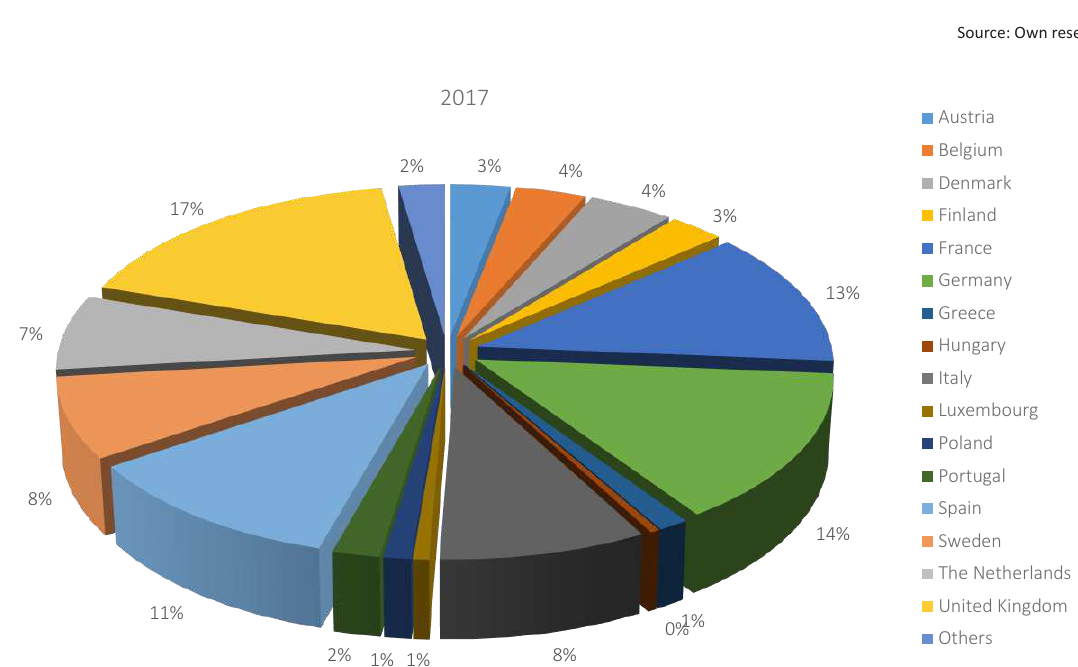
Figure 4. Percentage share of the number of integrated reports of individual member states in the EU as a whole in